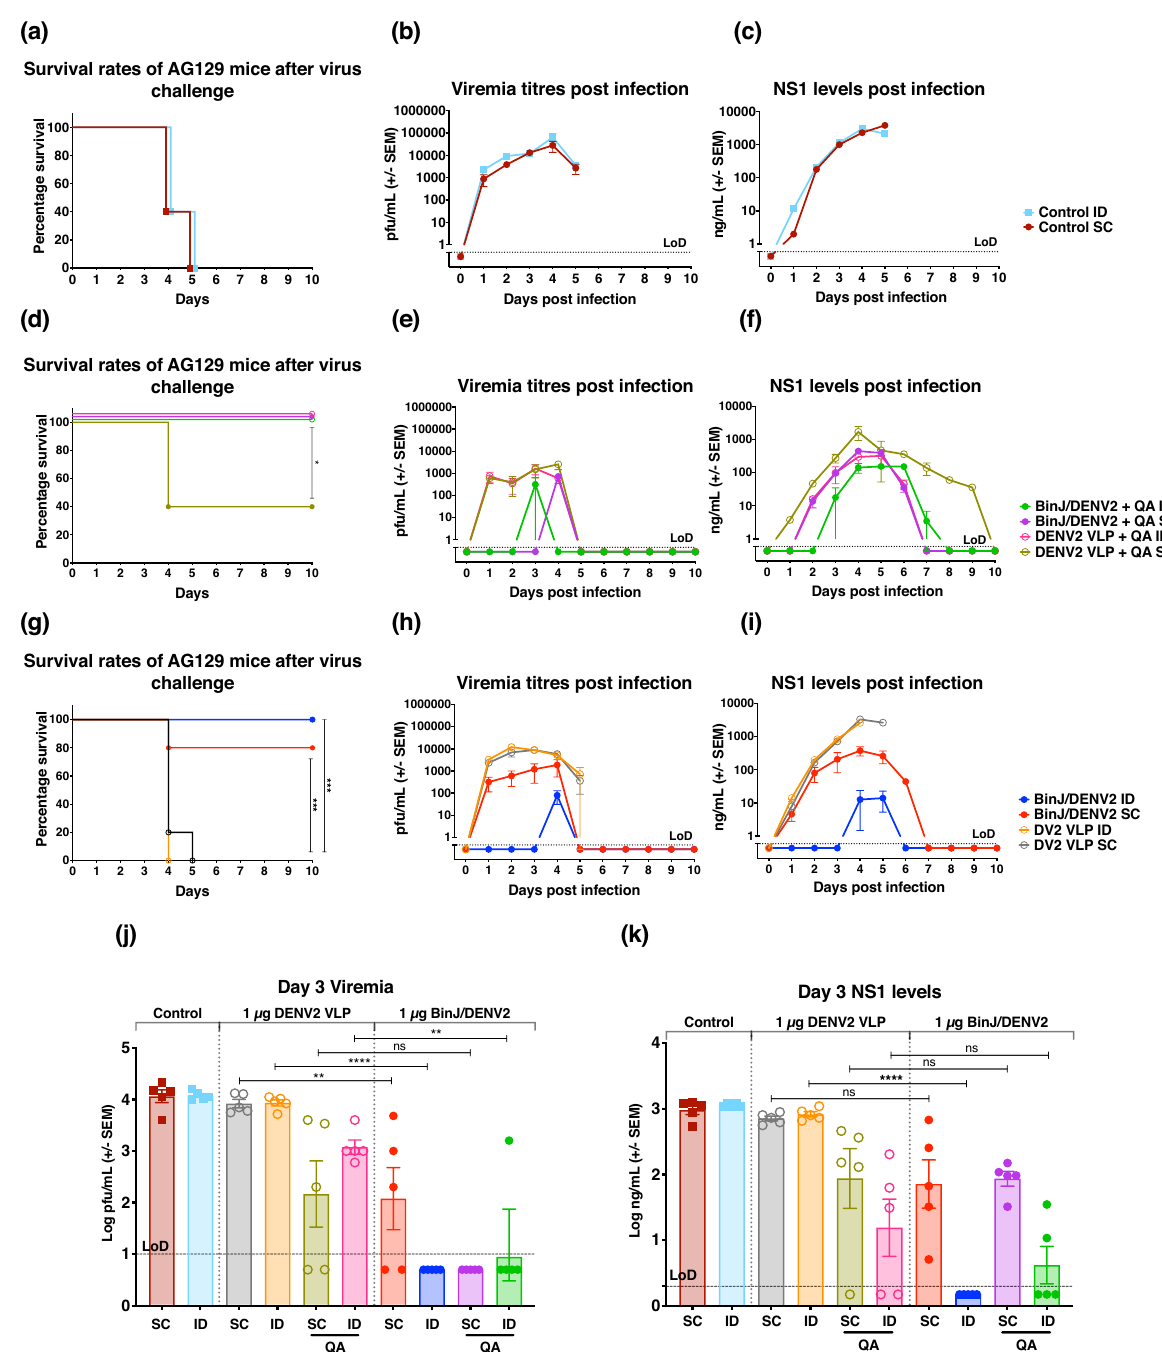
Fig. 3 Survival, viremia and NS1 secretion in mice following immunization and challenge. a , d , g Survival rates of mice over 10 days post challenge. b , e , h Mean viremia was determined by plaque assay on Vero cells. Limit of detection was 50 pfu/mL. c , f , i Serum levels of NS1 were determined using quantitative capture ELISA. To demonstrate the signi fi cant differences between j viremia and k NS1 levels, data from day 3 post virus challenge were plotted. Each symbol represents a single mouse. Lines indicate mean antibody titres with bars showing ±SEM. **** p ≤ 0.0001, *** p ≤ 0.0003, ** p ≤ 0.002, * p ≤ 0.03 assessed by one-way analysis of variance (ANOVA, α -level 0.05). mouse fl ank (Fig. 4c). HD-MAP coating with the vaccine desired dose of vaccine, we performed coating and delivery formulation revealed smooth and even distribution on the optimization of BinJ/DENV2-prME by HD-MAP. HD-MAPs were microprojections (Fig. 4b). Removal of vaccine was observed at coated with BinJ/DENV2-prME formulated with previously de fi ned the tip of the microprojections, con fi rming that the vaccine had excipients, 0.75% methylcellulose and 0.75% trehalose. Uncoated been delivered into the mouse skin (Fig. 4c). To quantify the (Fig. 4a) and coated HD-MAPs were imaged by scanning electron amount of delivered vaccine, a subtractive enzyme-linked microscopy (SEM) to observe coating uniformity before (Fig. 4b) immunosorbent assay (ELISA) was performed, measuring the and after coating removal following HD-MAP application to the Published in partnership with the Sealy Institute for Vaccine